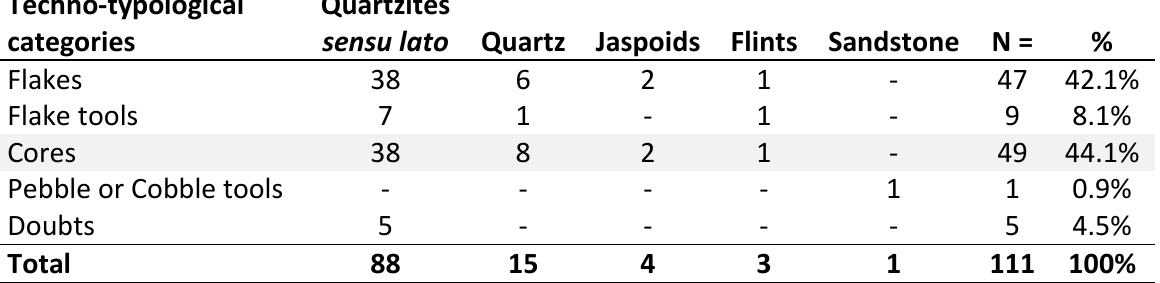
Table 6. Techno-typological main categories of Saint-Saturnin station.